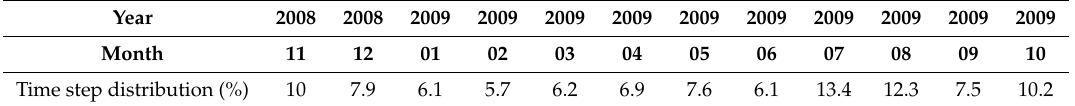
Table 4. Monthly distribution of the available